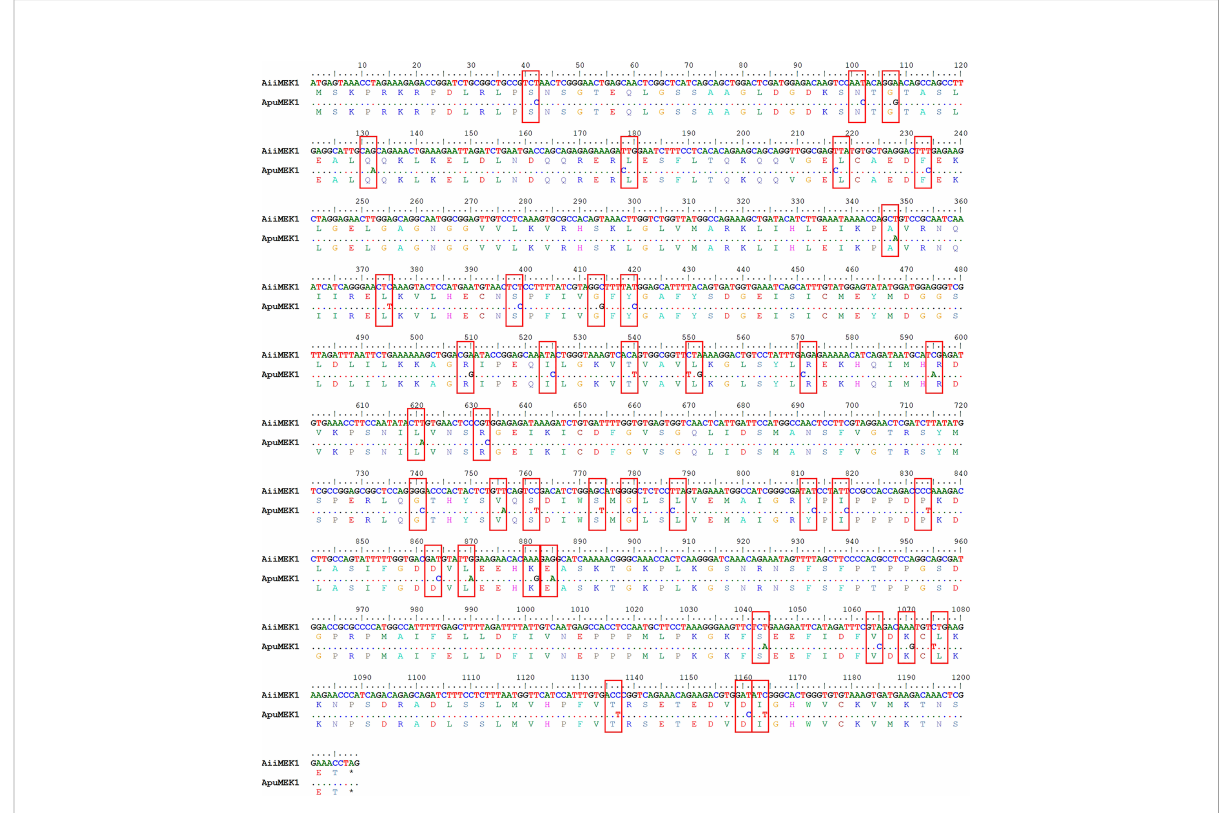
FIGURE 1 Nucleotide and amino acid variations between AiiMEK1 and ApuMEK1